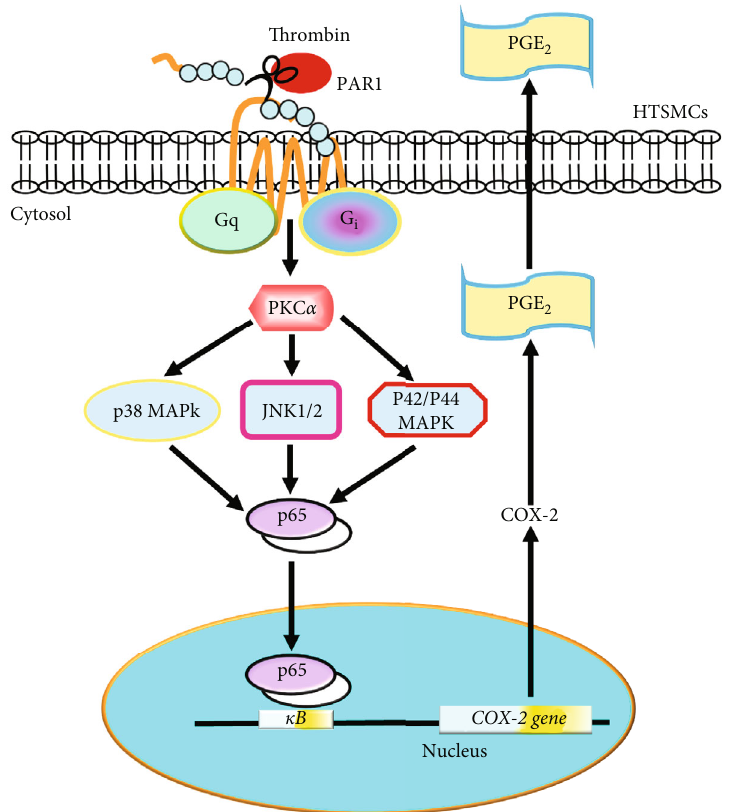
Figure 7: Schematic diagram illustrating the proposed signaling pathway involved in thrombin-induced COX-2 expression and PGE secretion in HTSMCs. Thrombin-induced COX-2 expression associated with PGE PKC α /MAPK-dependent NF- κ B activation in